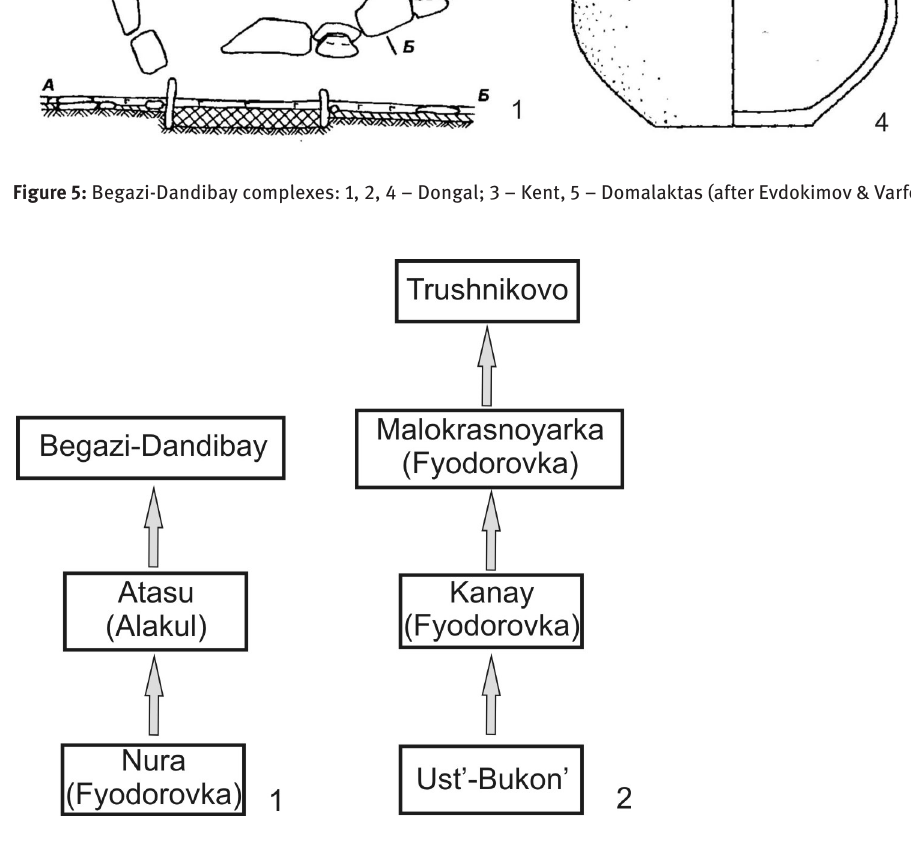
Figure 6: Schemes of Andronovo cultural genesis for Central (1) (Margulan et al., 1966) and Eastern (2) (Chernikov, 1960)